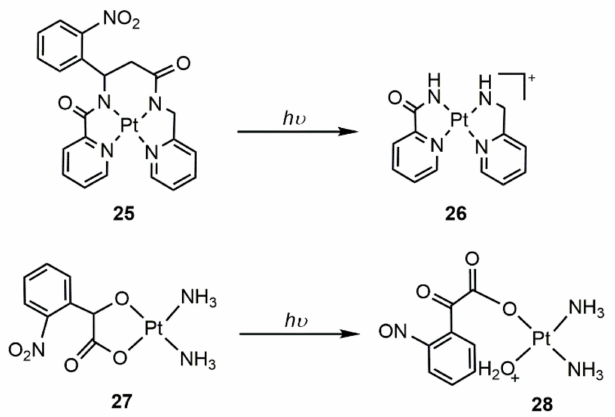
Figure 5. Chemical structures of photo-uncaging complexes 25 and 27 and their formed active species 26 and